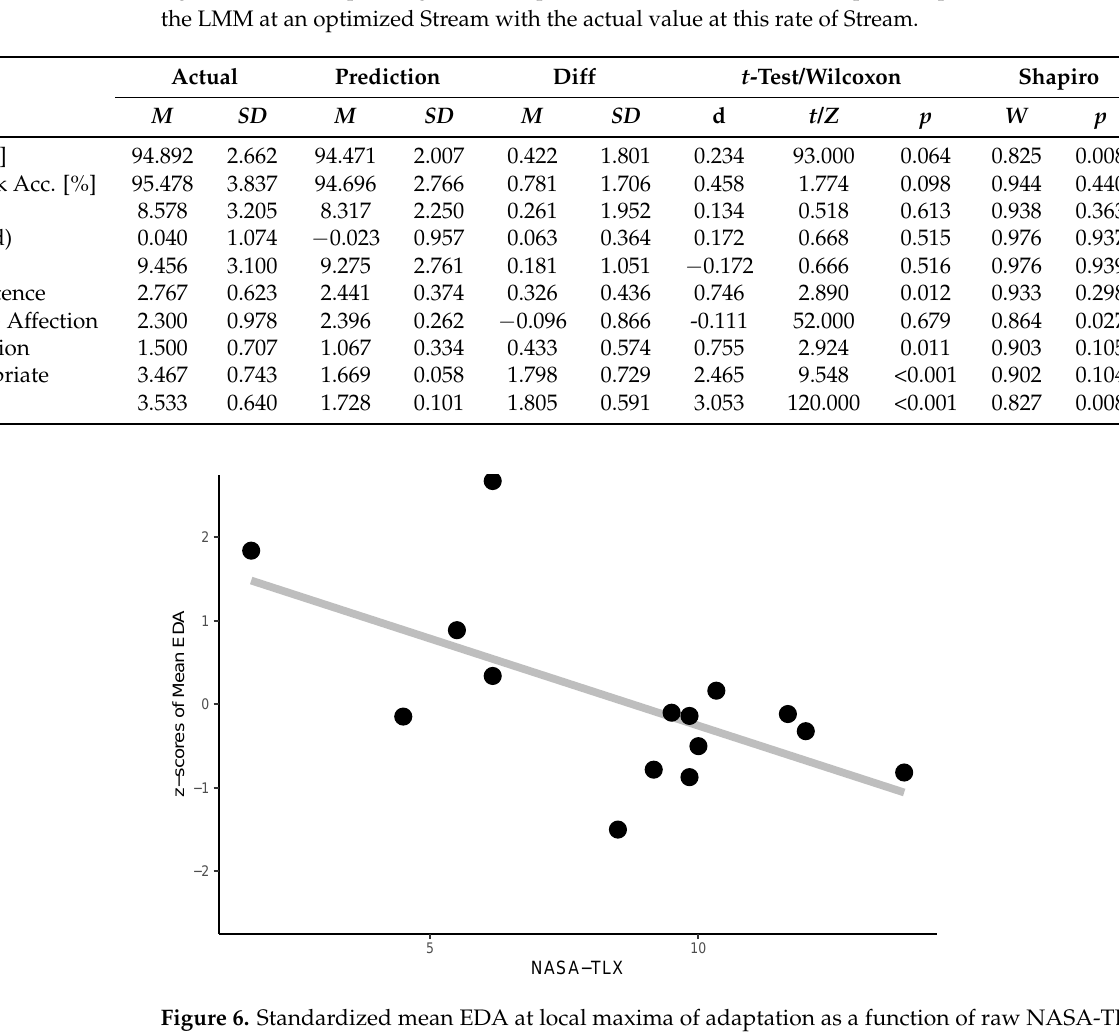
Figure 6. Standardized mean EDA at local maxima of adaptation as a function of raw NASA-TLX for the adaptive condition. There is a significant negative correlation between EDA and workload, r (13) = − 0.62, p =